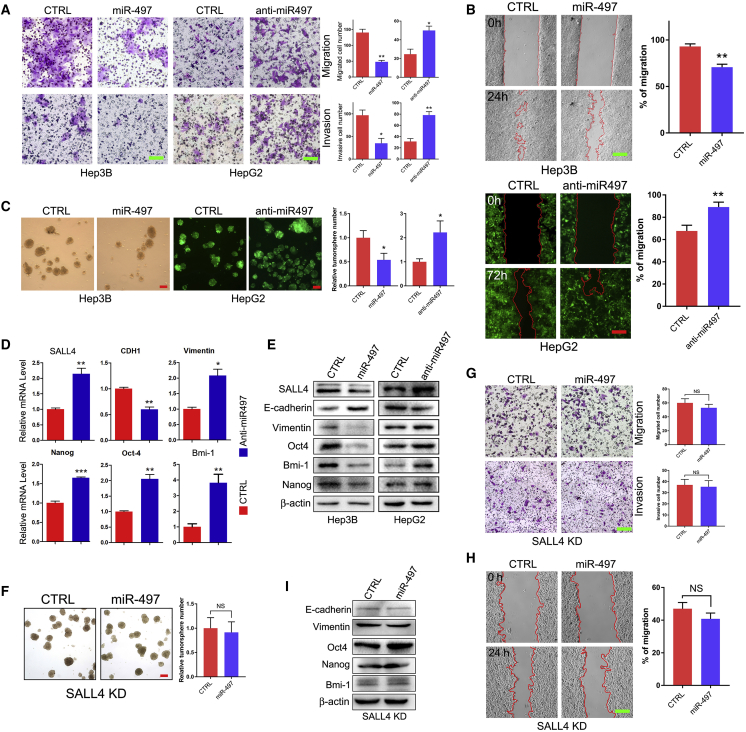
miR-497 Regulates HCC Metastasis and Self-Renewal(A) Hep3B and HepG2 cells transduced with miR-497 mimic, anti-miR497 vector, or control vector as indicated were subjected to cell migration and invasion assays. Migrated/invaded cells in fields were quantified, and representative photographs are shown. Data are represented as mean ± SEM. *p < 0.05; **p < 0.01. (B) Wound healing assay was performed to determine the cell migratory capacity. (C) Tumor sphere-forming capacity in HCC cell lines as indicated was analyzed by tumor sphere formation assay; the right panel indicates statistical results as means ± SEM. (D) qRT-PCR analysis of the mRNA expression of SALL4, CDH1, vimentin, Nanog, Oct4, and Bmi-1 in HepG2/Ctrl and HepG2/Anti-miR-497 cells. (E) Western blot analysis of SALL4, E-cadherin, vimentin, Oct4, Bmi-1, and Nanog expression in Hep3B/Ctrl and Hep3B/miR-497 cells, as well as in HepG2/Ctrl and HepG2/anti-miR-497 cells. (F) SALL4 knockdown abolished sphere formation ability reduced by miR-497. Representative sphere formation is indicated in the left panel. Relative tumor sphere numbers were calculated as means ± SEM (right panel). (G and H) SALL4 knockdown abolished migration and invasion capacity down-regulated by miR-497 as analyzed by Transwell assay (G) and wound healing assay (H). (I) The expression of E-cadherin, vimentin, Oct4, Bmi-1, and Nanog was detected in SALL4 KD/Ctrl and SALL4 KD/miR497 HCC cells. *p < 0.05; **p < 0.01. Scale bars, 100 μm.